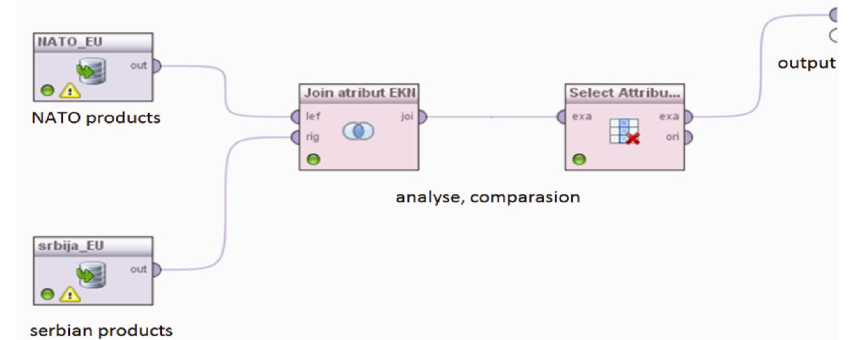
Figure 4 – Data analysis, finding commom features Рис . 4 – Процесс анализа , поиск общего признака